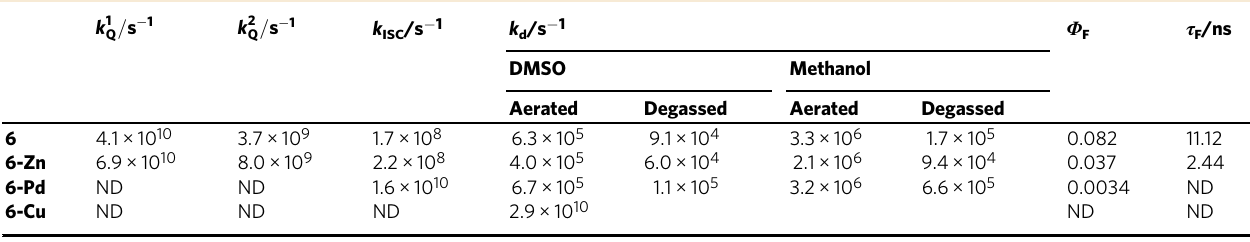
Table 2 Major Photophysical and Photochemical Processes Observed in 6, 6-Zn, 6-Pd, and 6-Cu a . k 1 = s (cid:1) Q